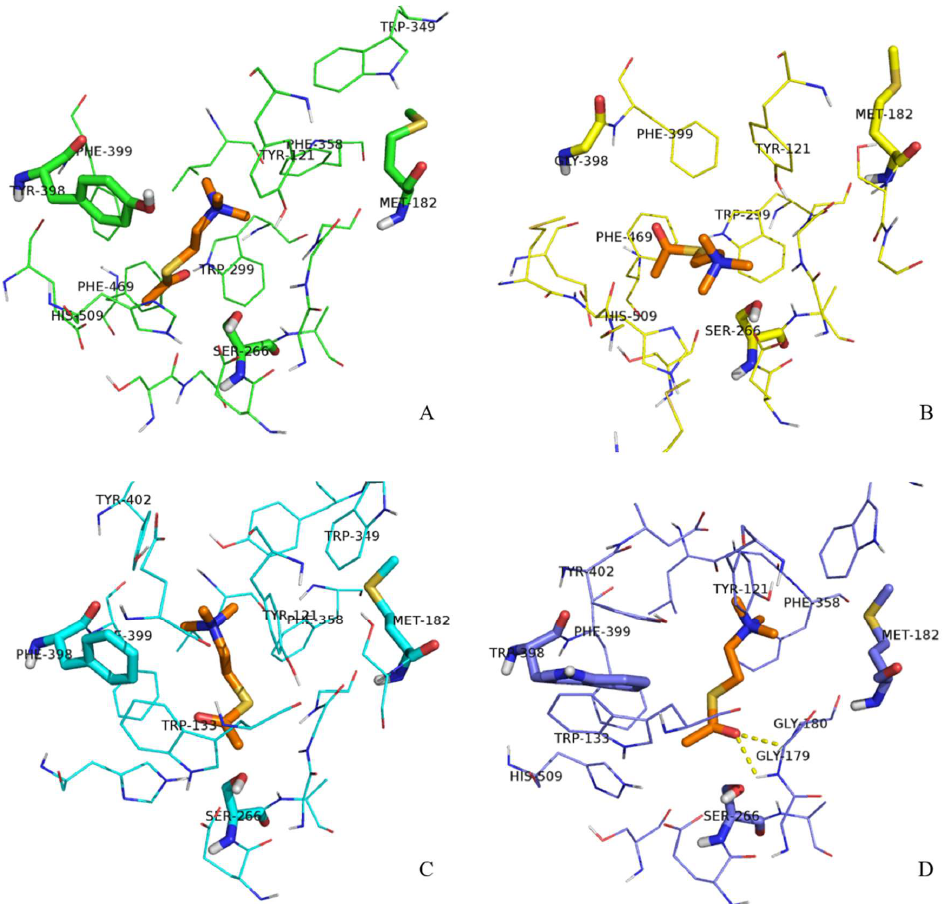
Figure 6. Conformations of ATChI after pulling under 200 KJ · mol − 1 · nm − 1 for 1 ns. Substrate ATChI was presented by orange sticks. The structure of the gorge residues and catalytic S266 of wild type enzyme Y398 ( A ), Y398G mutant ( B ), Y398F mutant ( C ), and Y398W ( D ) mutant of r Bm AChE II are shown.